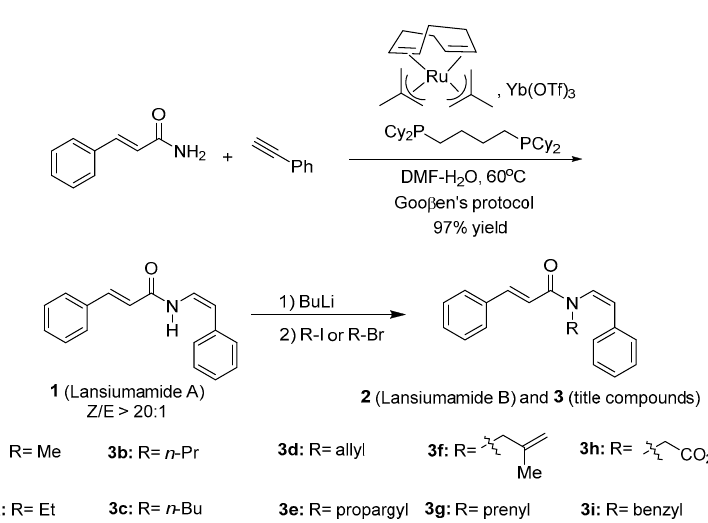
Scheme 1. General synthetic procedure for title compounds.